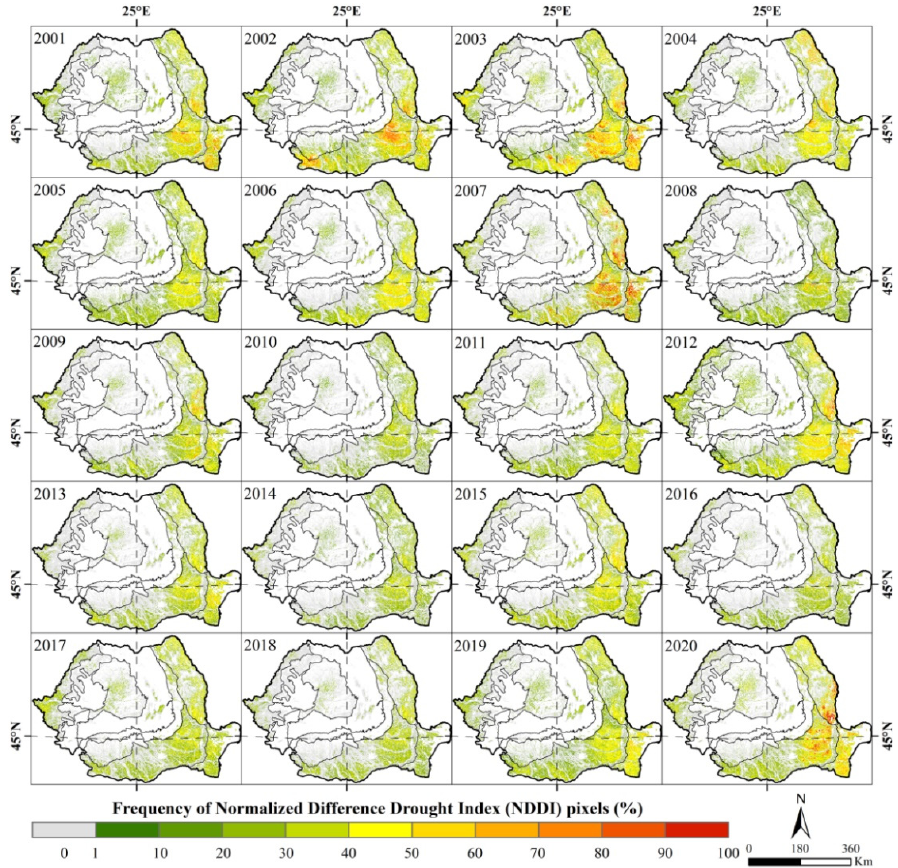
Figure 4. Spatial relative frequency of the drought classes (NDDI >0.5) at the annual level for the arable lands in Romania according to the NDDI between 2001 and 2020.